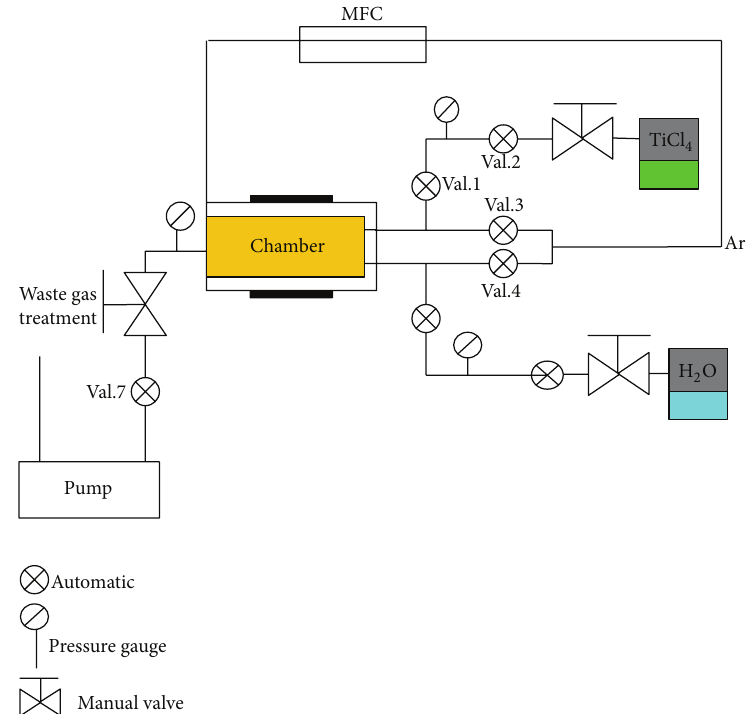
Figure 1: Schematic of the ALD system.